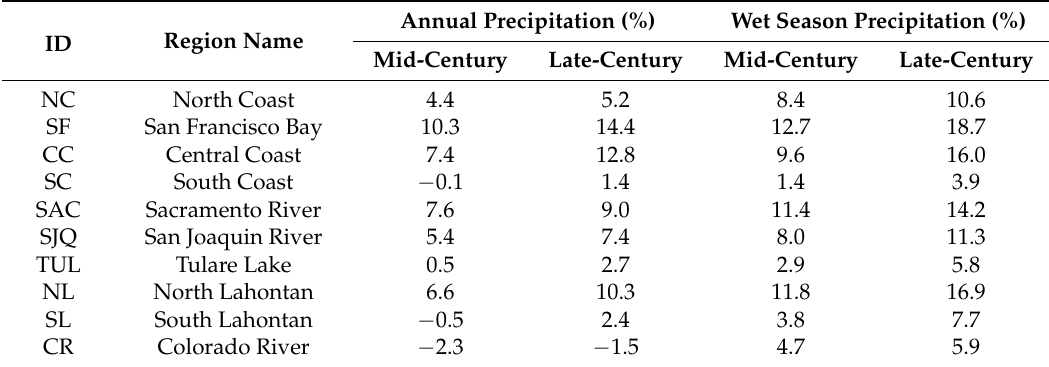
Table 3. Percent differences (%) between historical and mean RCP 8.5 projections on annual precipitation and wet season